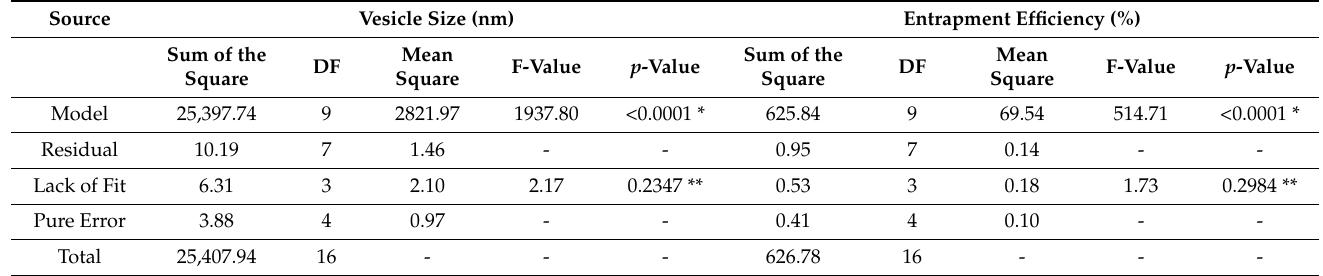
Table 2. Analysis of variance table for responses with the best-fitted quadratic